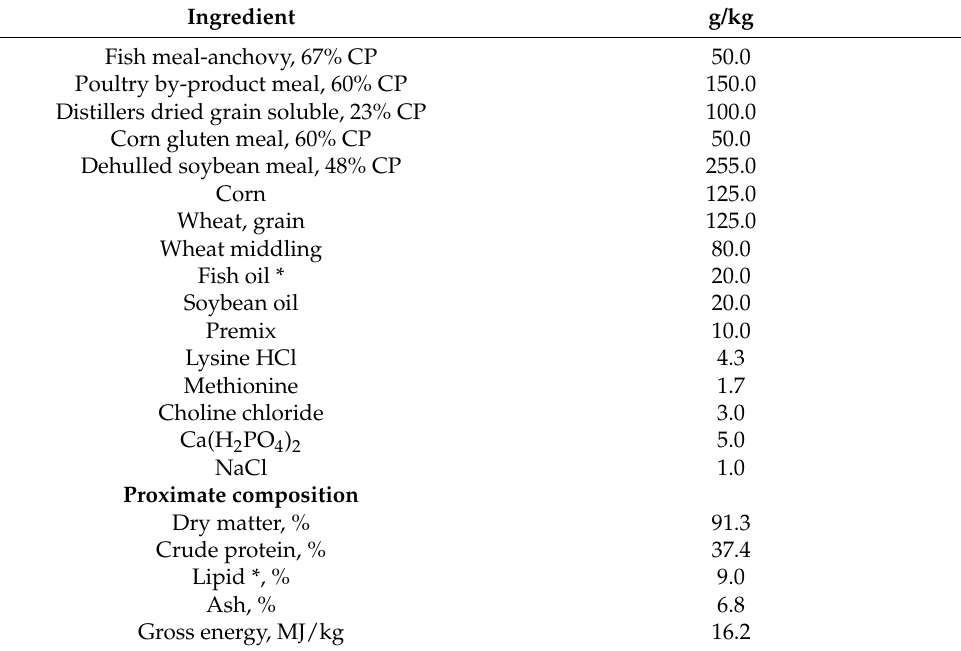
Table 1. Ingredient and proximate chemical compositions of the test diets. Ingredient g/kg Fish meal-anchovy, 67% CP 50.0 Poultry by-product meal, 60% CP 150.0 Distillers dried grain soluble, 23%